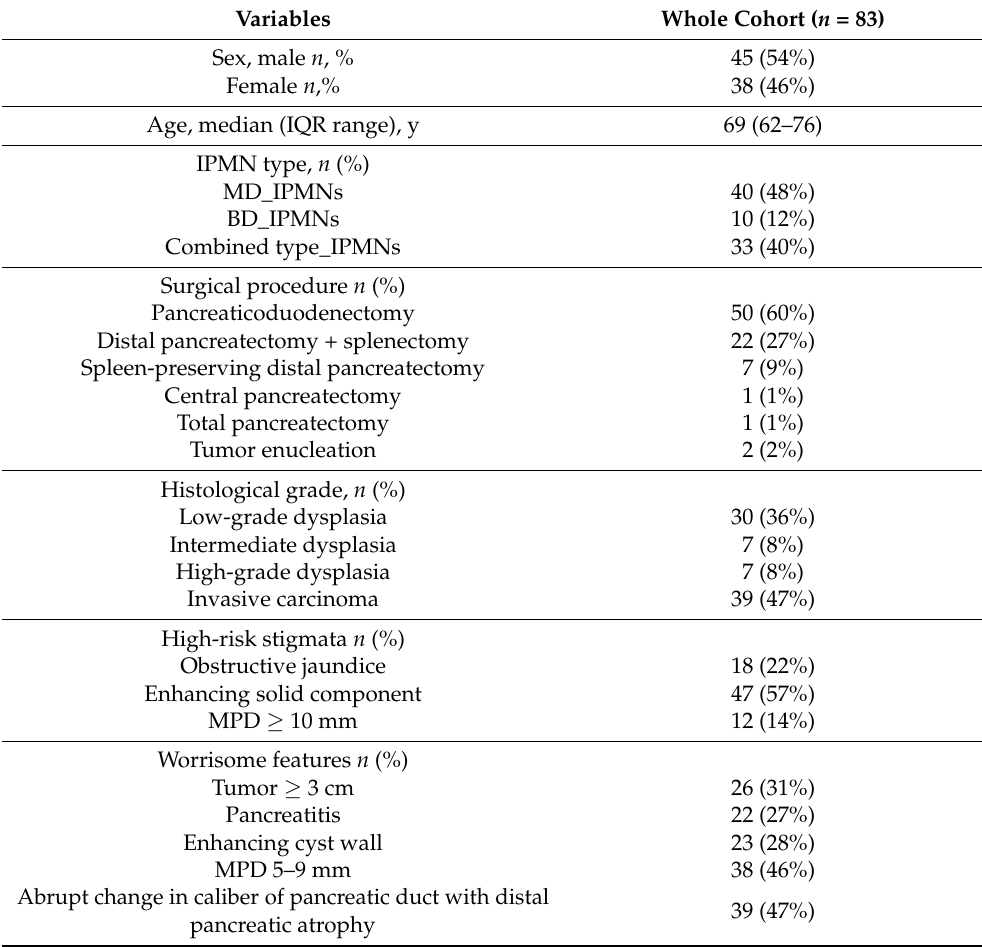
Table 1. Clinicopathological features of the whole cohort. IPMN, intraductal papillary mucinous neoplasm; MD, main duct; BD, branch duct; MPD, main pancreatic